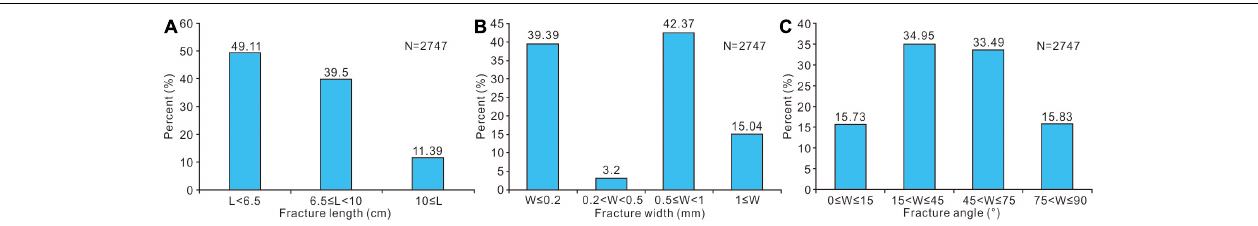
FIGURE 6 | (A) Percent of fracture length with the different scale from the Wufeng-Longmaxi Formation, southeastern Chongqing. (B) Percent of different fracture width in the Wufeng-Longmaxi Formation, southeastern Chongqing. (C) Percent of different Fracture angle in the Wufeng-Longmaxi Formation, southeastern Chongqing. N denotes the number of fractures.